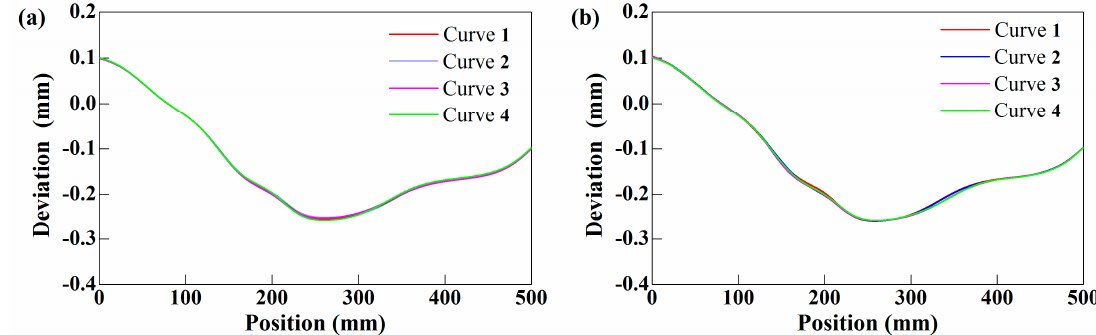
Figure 32. Combined projection curves ( a ) PD is the measured surface ( b ) PC is the measured surface.